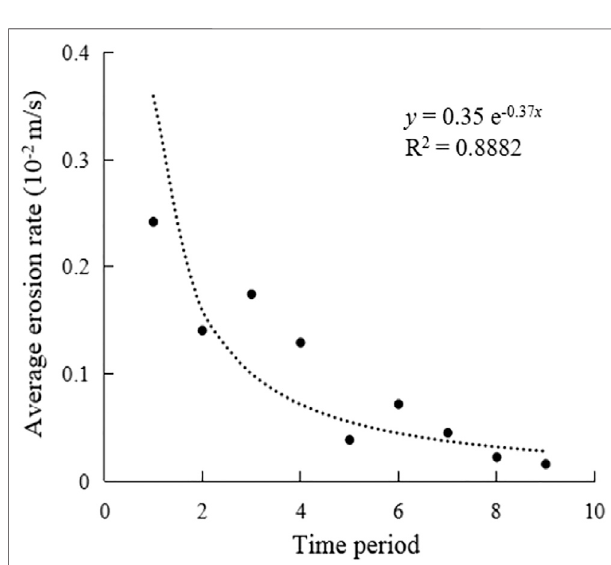
FIGURE 8 | Decrease of the erosion rate with time.